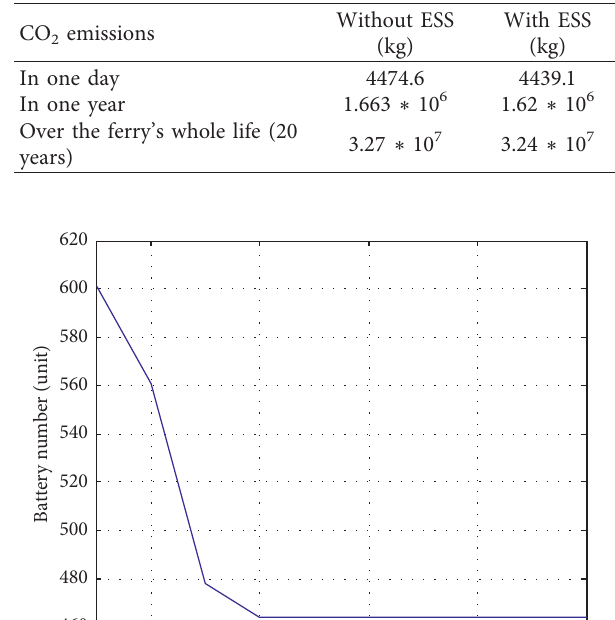
Table 4: CO 2 emission of DGs with/without ESS.